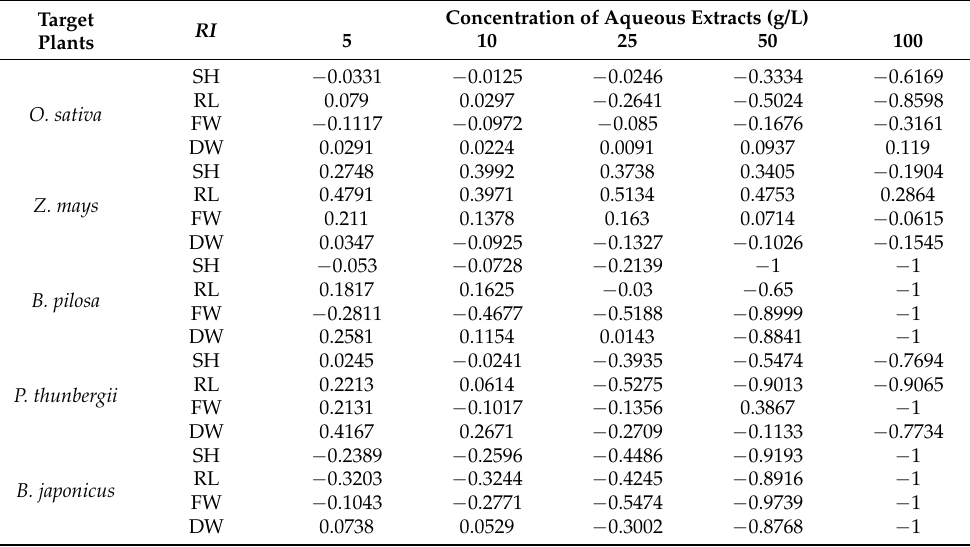
Table 3. Response index of extracts from fleagrass aerial parts on the growth of five target plant species. Target